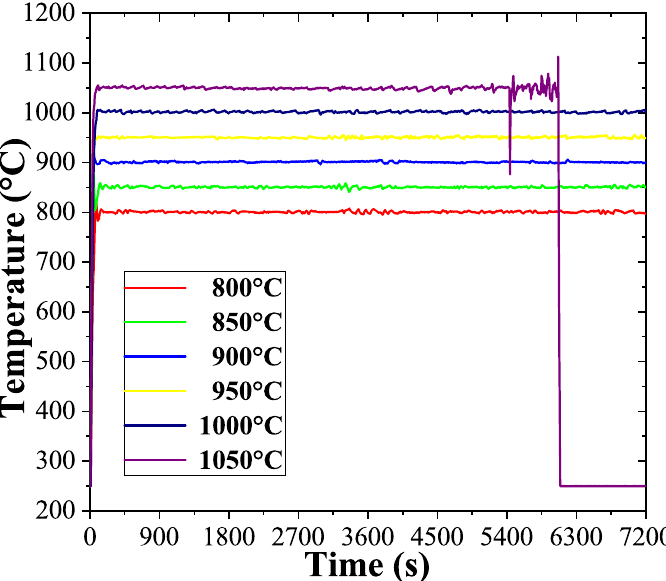
Figure 4. Thermal history measured in the middle of the notch for different oxidation